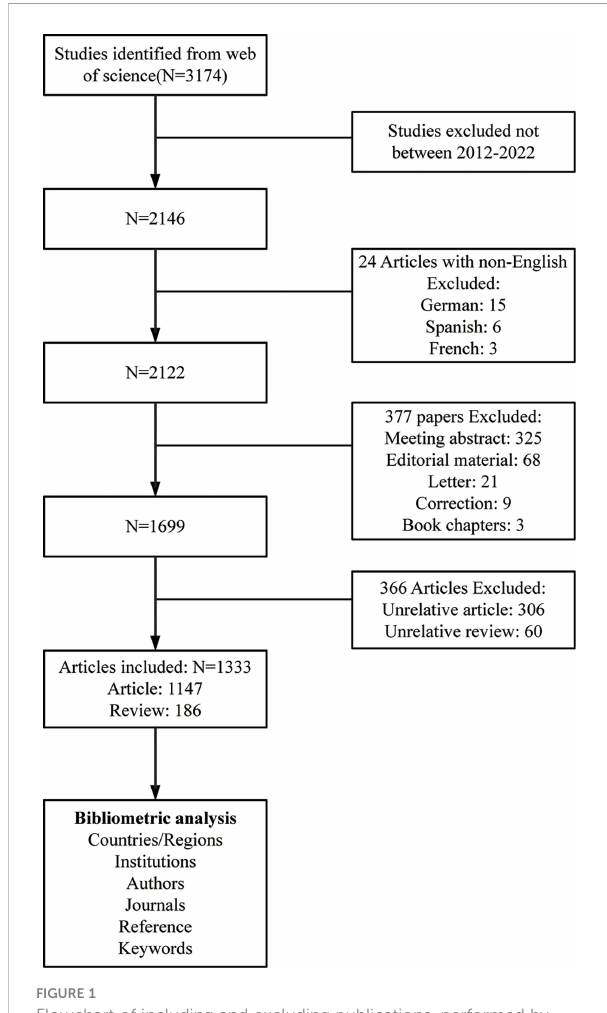
FIGURE 1 Flowchart of including and excluding publications, performed by Microsoft